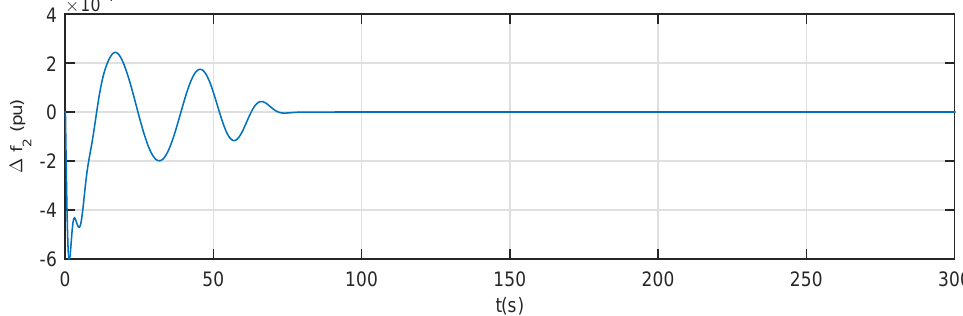
Figure 7. Frequency responses area 2 of a two-area traditional LFC model with time-varying